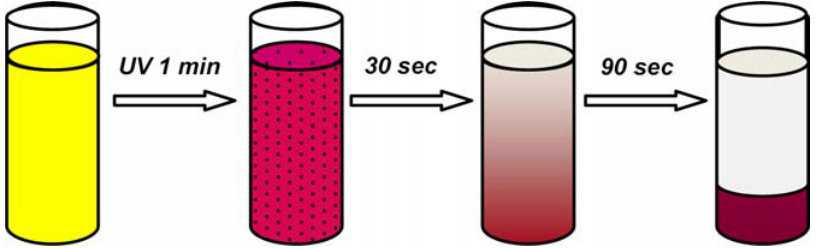
Figure 16. UV-induced aggregation and sedimentation of colloidal silica nanoparticles with spiropyran